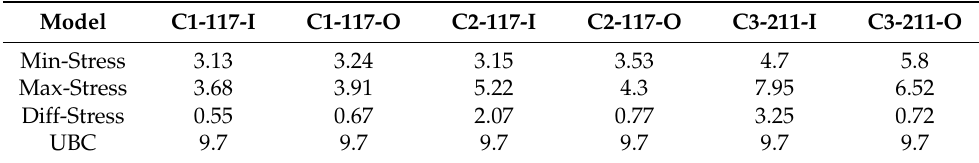
Table 5. Comparison of stresses on top of the piles among different schemes